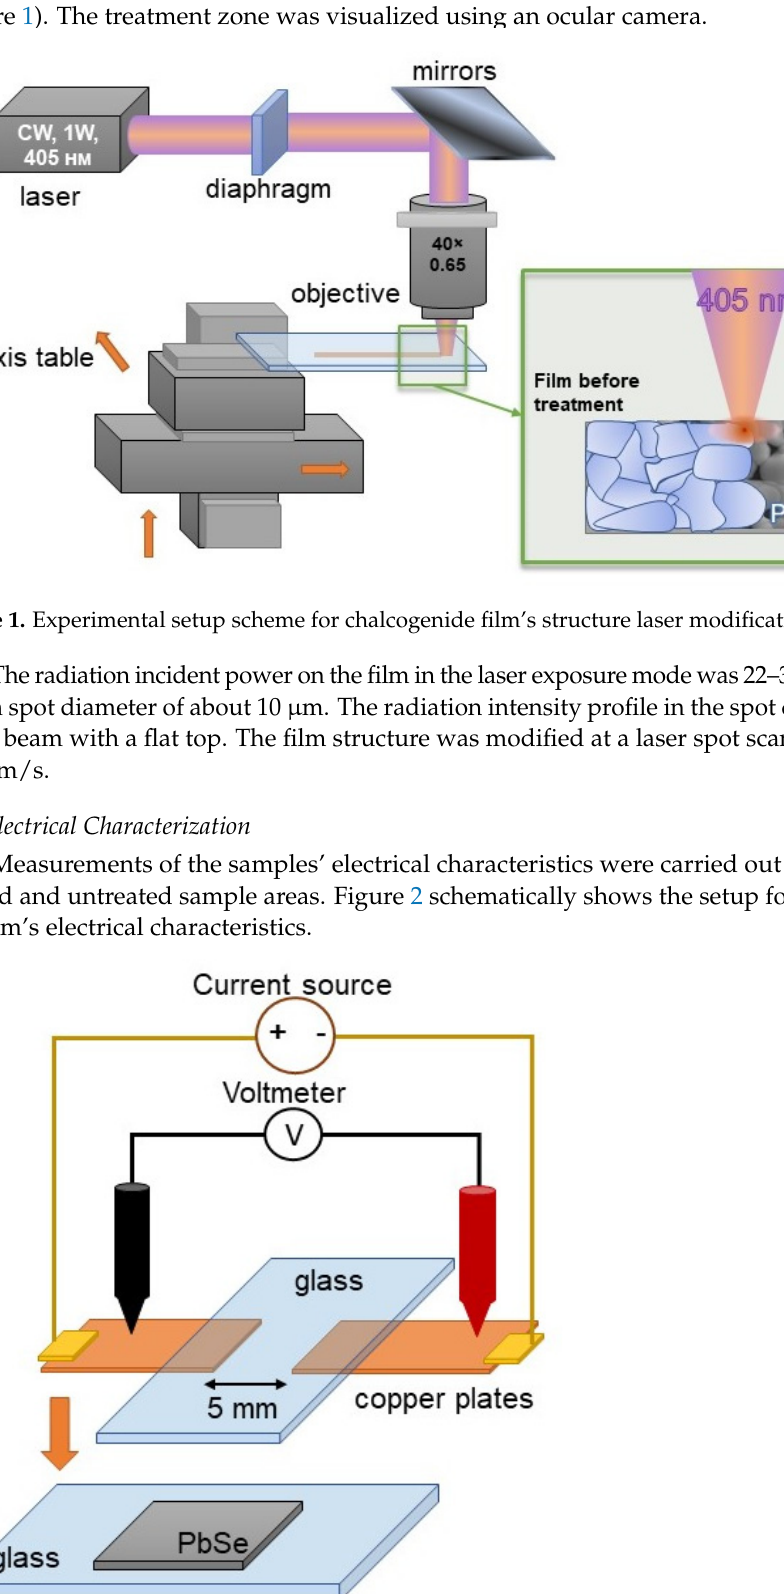
(Figure 1). The treatment zone was visualized using an ocular camera.